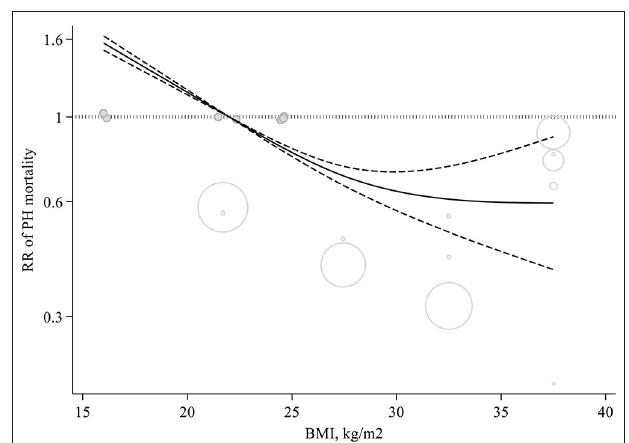
FIGURE 3 | Non-linear dose-response meta-analysis of cohort studies investigating the association between body mass index and mortality among pulmonary hypertension patients ( P <